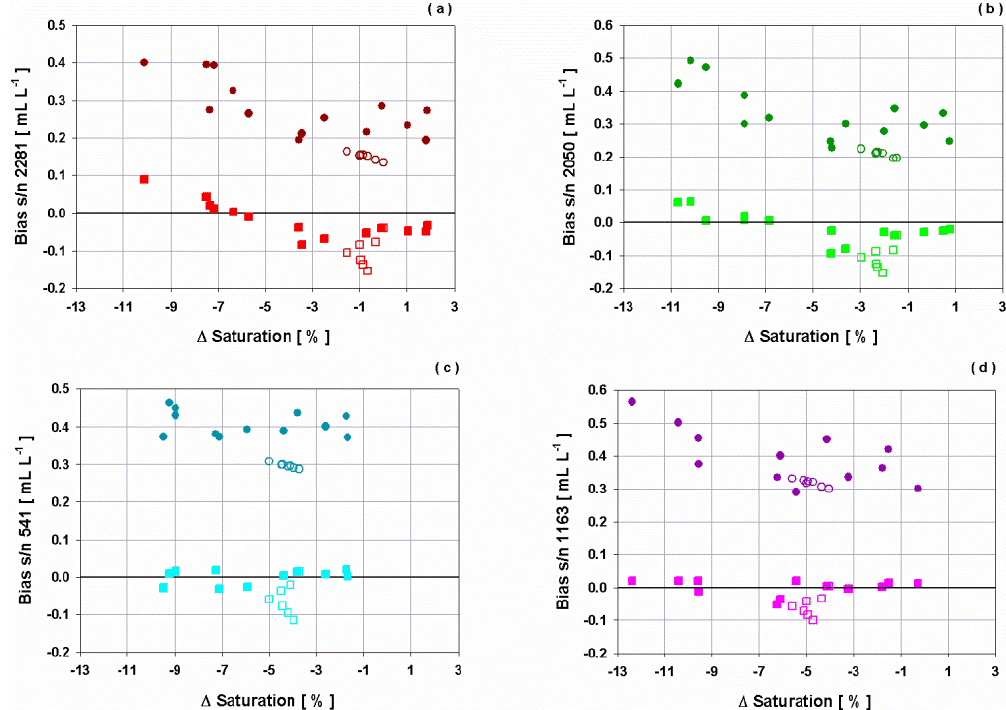
Figure 10. Bias of dissolved oxygen concentration with respect to saturation offset for SBE43 sensors ( a ) s/n 2281, ( b ) s/n 2050, ( c ) s/n 541, ( d ) s/n 1163 before (dot) and after (square) the SOC adjustment at constant salinity and varying temperature (full marker) and at constant temperature and varying salinity (empty marker).